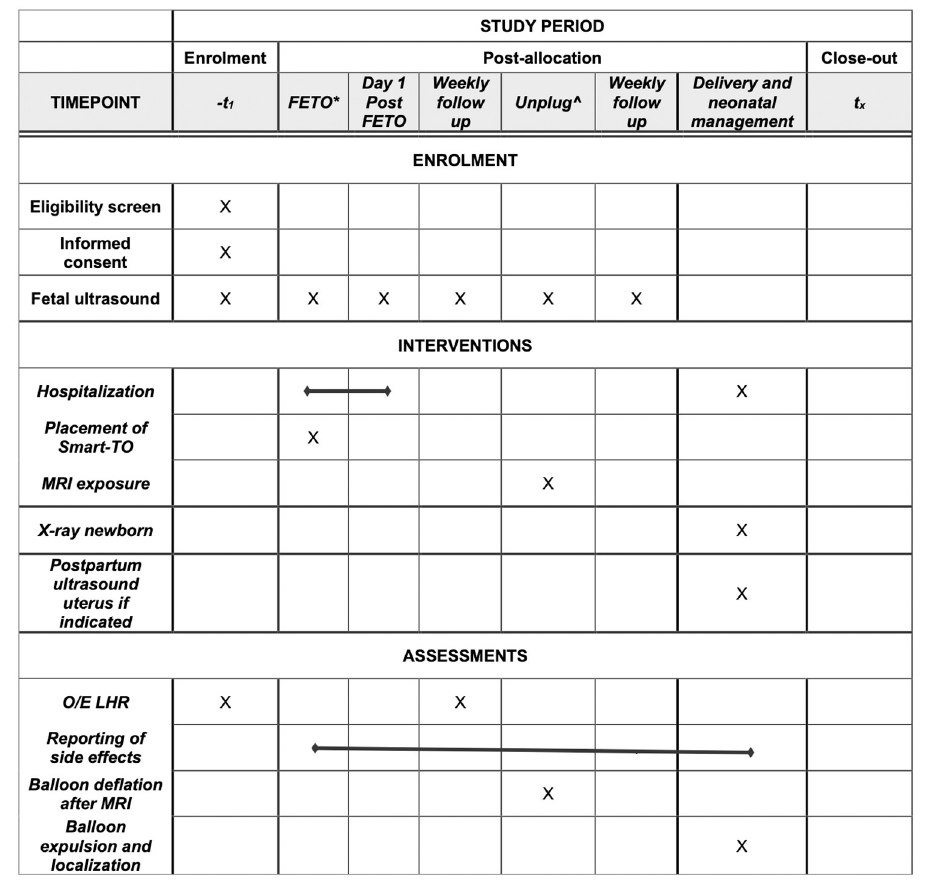
Fig 1. SPIRIT schedule. Abbreviations: FETO, Fetoscopic Endoluminal Tracheal Occlusion; O/E LHR, observed-to- expected lung-to-head ratio; MRI, Magnetic Resonance Image.